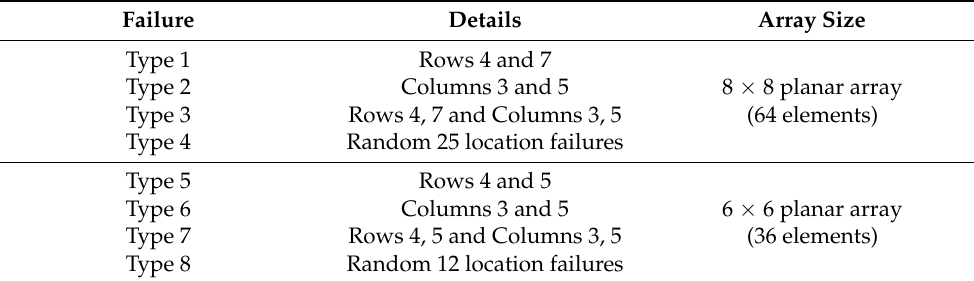
Table 2. Failure types for 8 × 8 and 6 × 6 planar arrays.